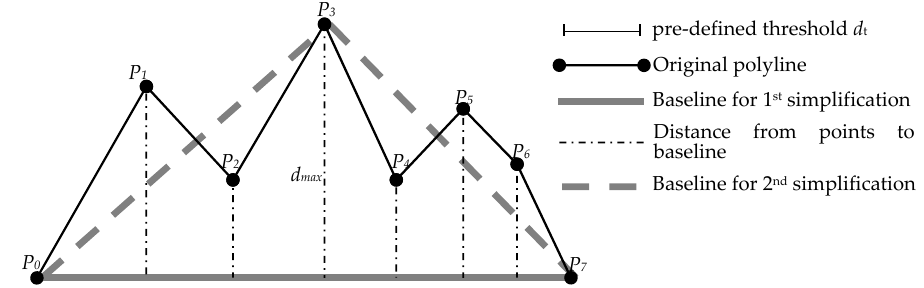
Figure 1. Schematic diagram of DP algorithm.